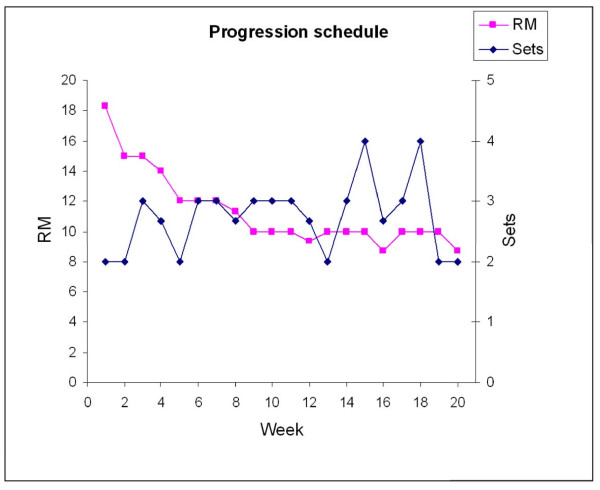
Progression of relative intensity, i.e. repetition maximum (RM), and number of sets per exercise session throughout the 20 week training period. Notice that RM was decreased, i.e. the relative intensity increased, while the number of sets was slightly increased, but in an undulating fashion, during the training period. Data points represent weekly mean values of all sets and exercises from the training diaries of the training group (n = 282).